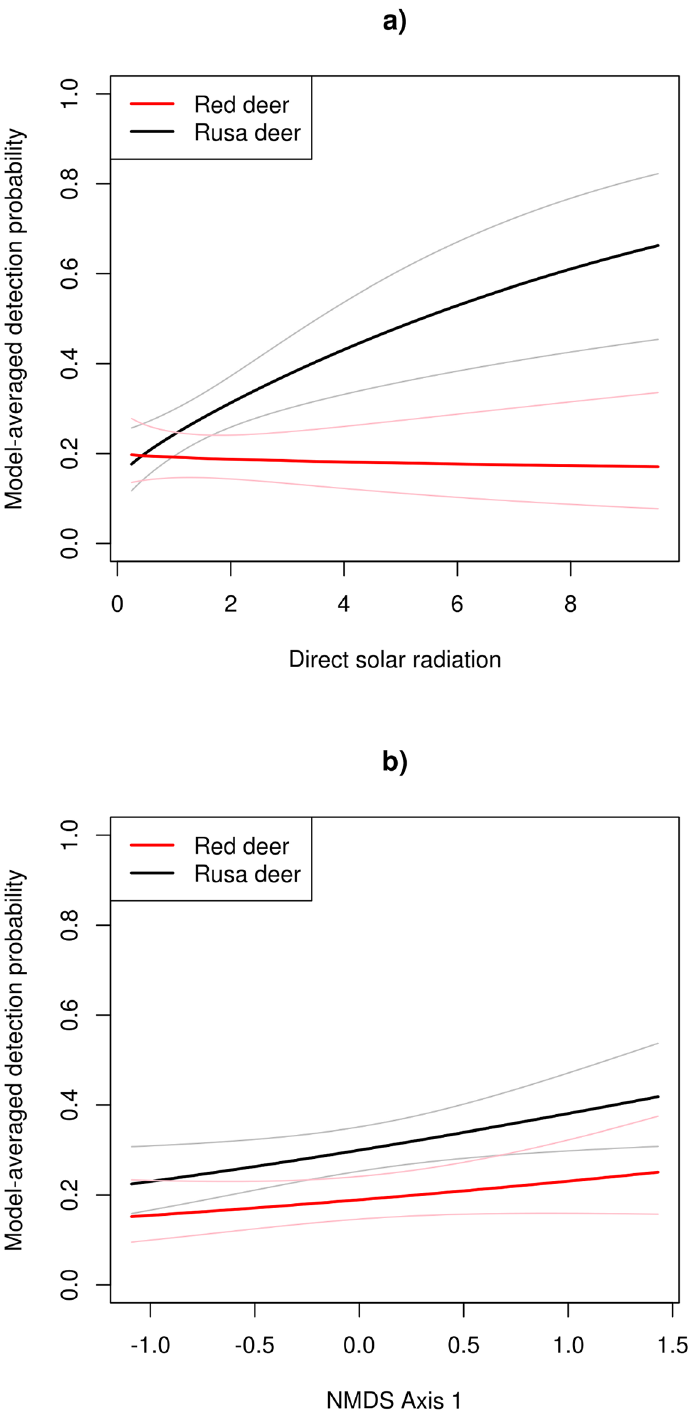
Fig 6. Model-averaged detection probability of rusa deer and red deer in summer 2011. Model- averaged detection probability of rusa deer and red deer in summer 2011 as a function of direct solar radiation (total mols m -2 day -1 ) transmitted through the canopy ( a ), and non-metric multidimensional scaling axis 1 (NMDS Axis 1) scores ( b ). Lighter lines indicate 95% confidence